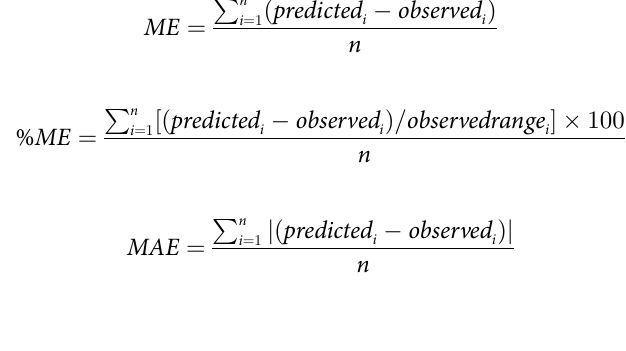
In joint moment changes, positive values indicate increase of the peak and negative values indicate decrease of the peak; ext, extension; flex, flexion; plant, plantarflexion; dors, dorsiflexion; the resulting posture for each manipulation is shown in Fig